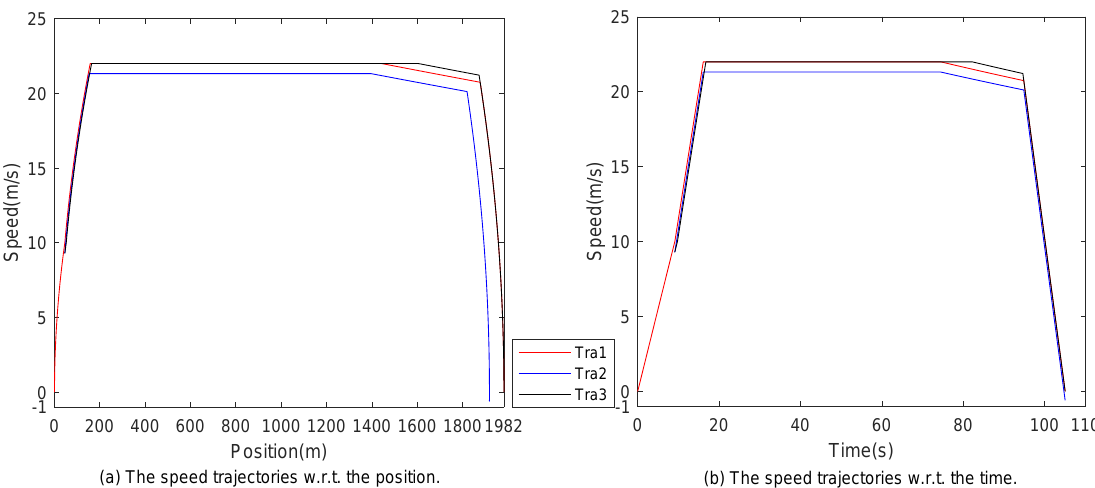
(b) The speed trajectories w.r.t. the time.(a) The speed trajectories w.r.t. the position.